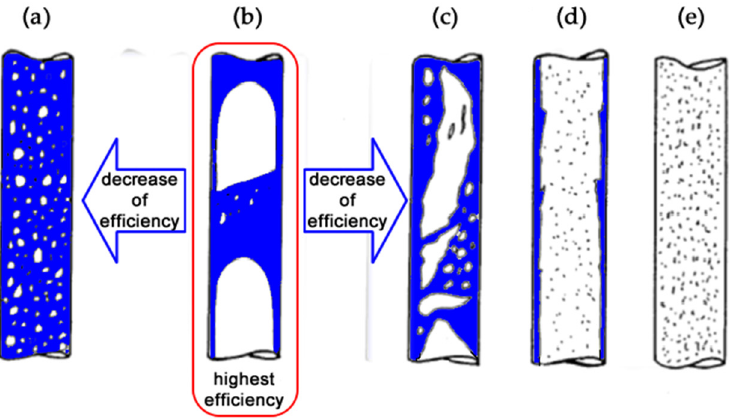
Figure 6. Two-phase flow structures: ( a ) bubble flow; ( b ) slug flow; ( c ) froth flow; ( d ) annular flow; ( e ) mist flow.